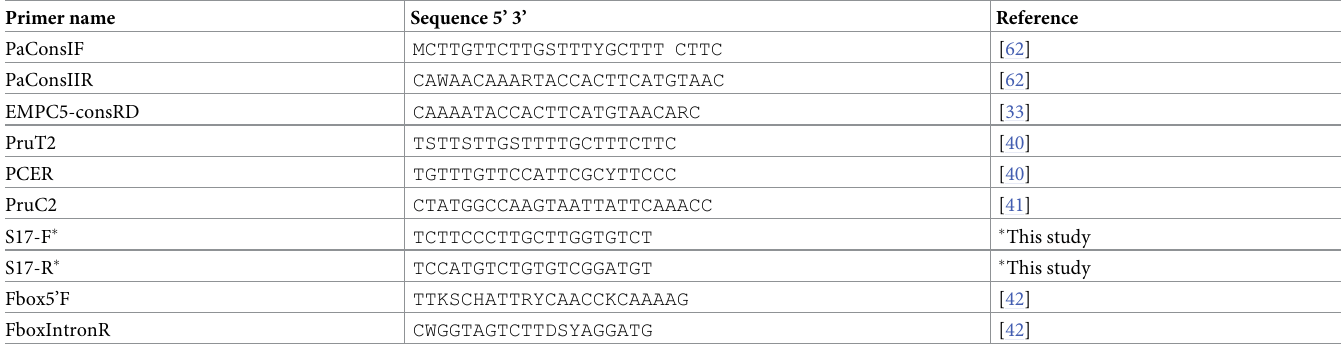
Table 3. Sequence information of the primers used and designed in this